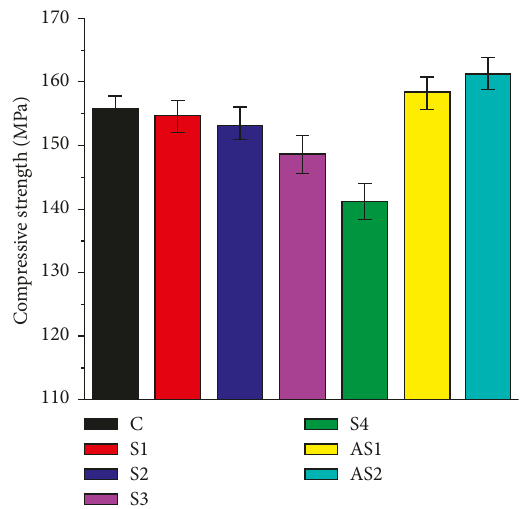
Figure 9: Compressive strengths of the concretes at